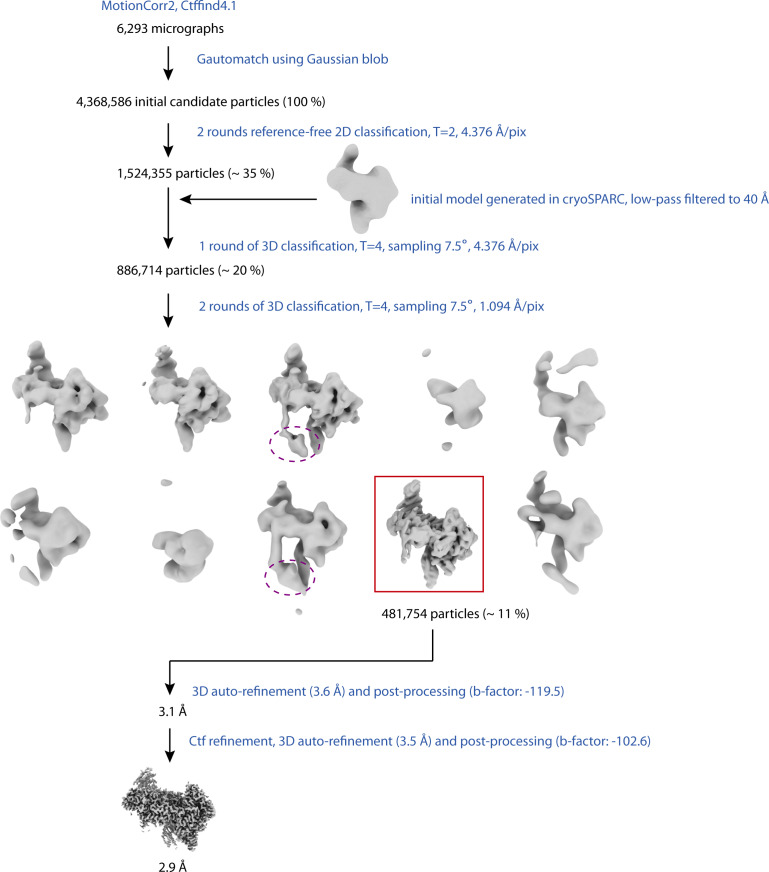
Cryo-EM data processing scheme.Processing steps are indicated in blue; particle numbers of classes used for downstream processing steps (in brackets: percentage with respect to initial candidate particles) and resolutions are in black. The class selected for the 3D refinement after the last step of 3D classification is indicated by a red rectangle. Density for the unmodelled, C-terminal part of SMG8 appearing in two other 3D classes not used for the final reconstruction is highlighted in magenta. This part of SMG8 has been suggested to contribute to kinase regulation (Zhu et al., 2019).